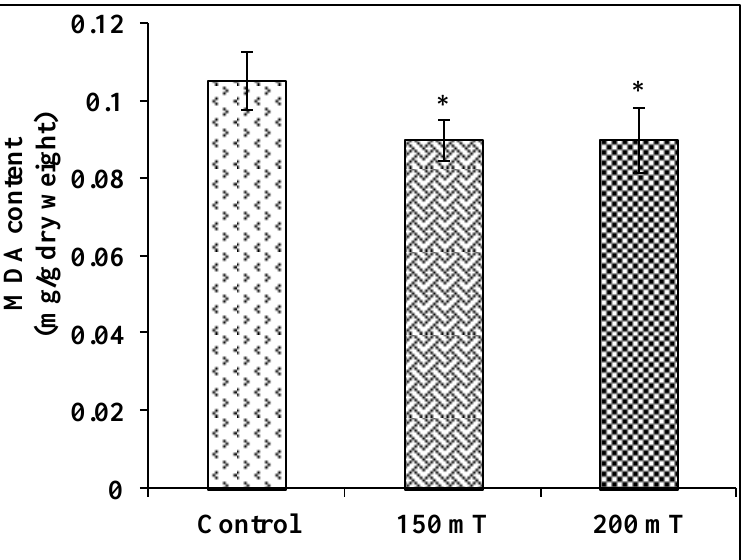
Figure 13. Effect of pre-sowing magnetic field treatment of soybean seeds on MDA content. * indicates significance at p < 0.05, compared to control.